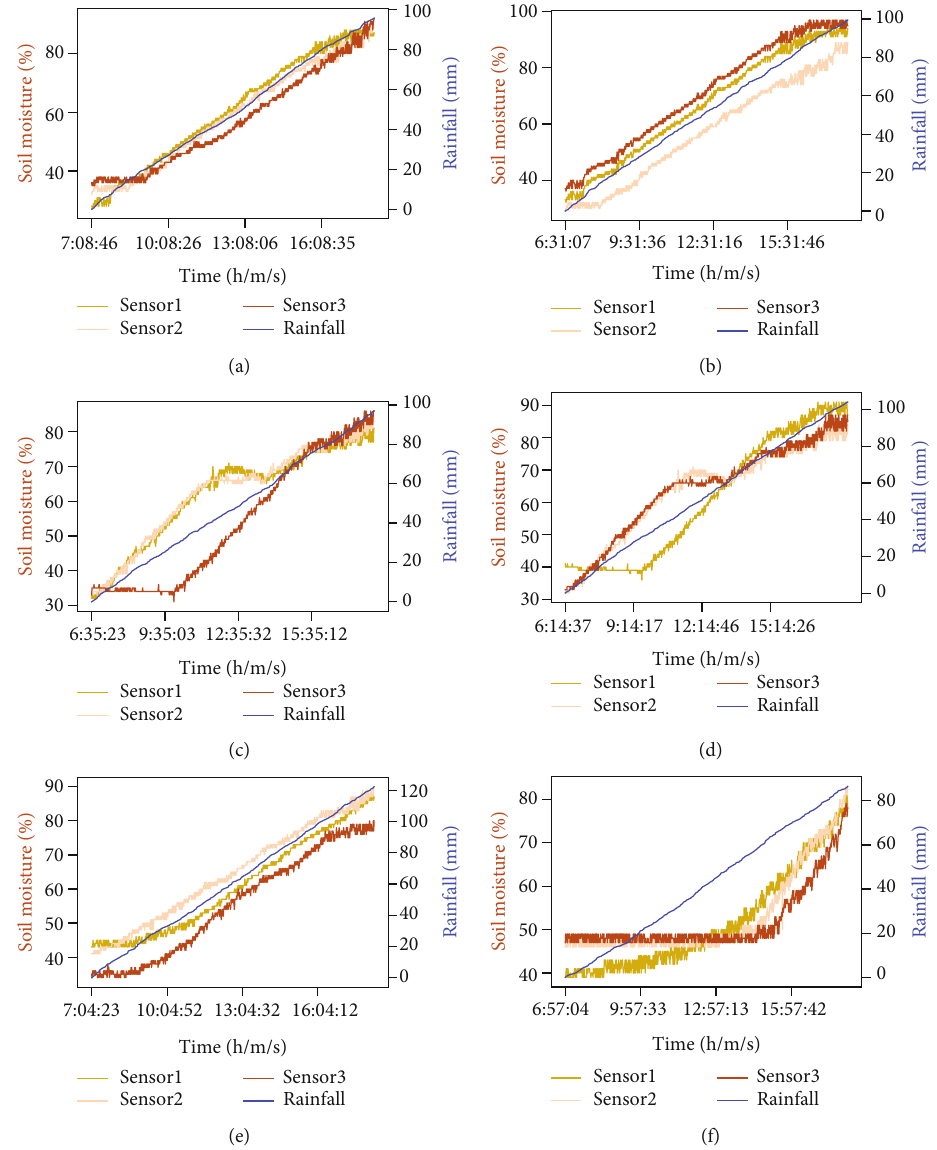
Figure 10: Variation of soil moisture content versus rainfall for sites SA2 (a, b), SB (c, d), and SE1 (e,